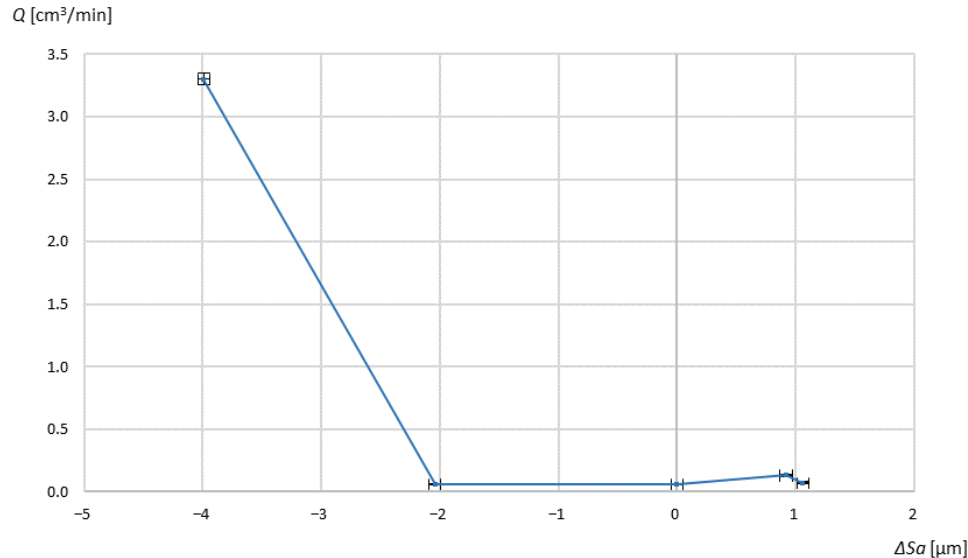
Figure 14. The value of leakage Q as a function of the difference in the value of the surface topogra- phy parameter Sa for a constant compressive force of 2280 N for the base surface with a value of Sa = 1.25 µm.